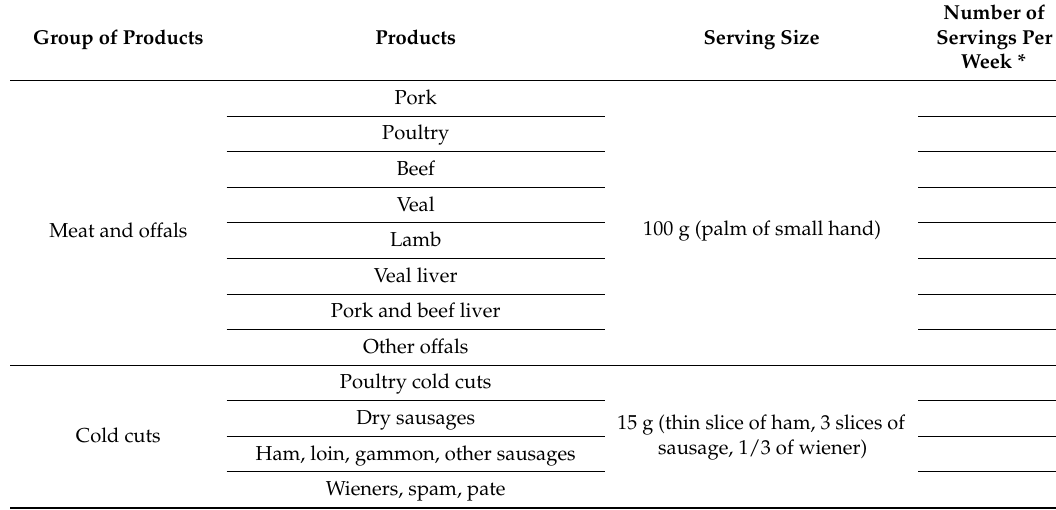
Table 1. The designed ZINC-food frequency questionnaire